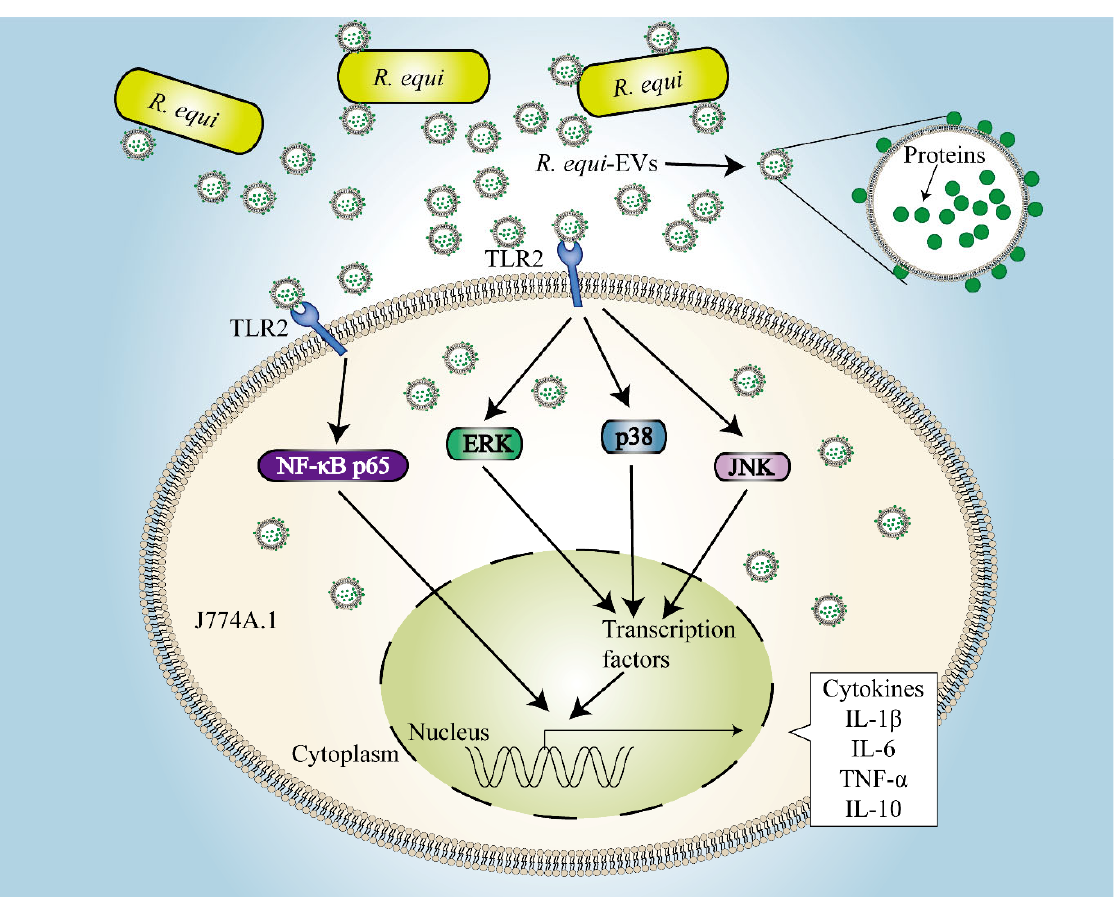
Figure 8. The model of R. equi ‐ derived extracellular vesicles ( R. equi ‐ EVs) promoting inflammatory response in macrophage through TLR2 ‐ NF ‐κ B/MAPK